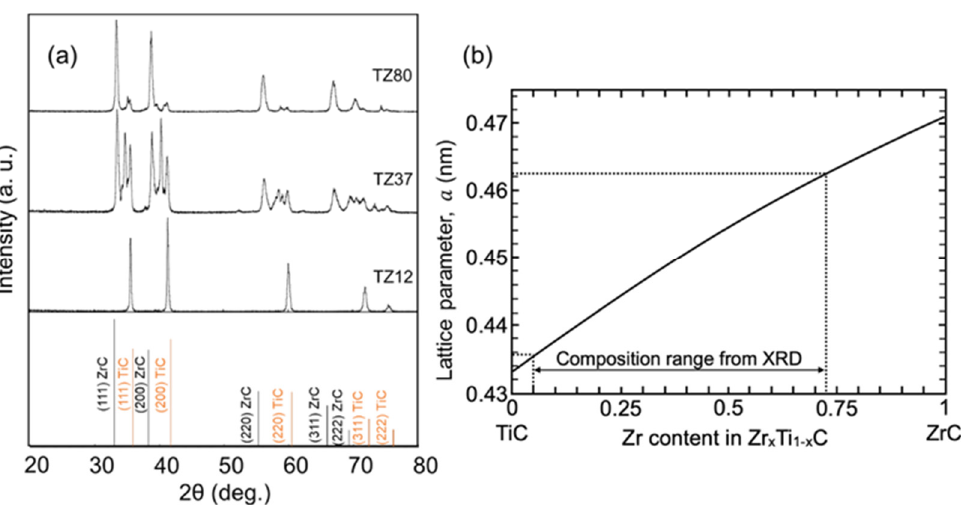
Figure 8. ( a ) Powder X-ray diffraction (XRD) patterns obtained after infiltration into model preforms. ( b ) Relationship between lattice parameter and Zr content in Zr x Ti 1-x C.